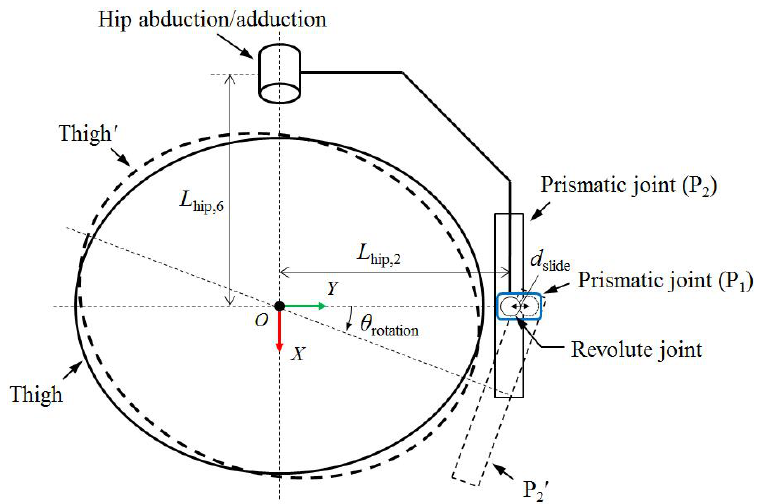
Figure 3. Schematic of the remote-center rotation of hip medial/lateral joint in the transversal view.